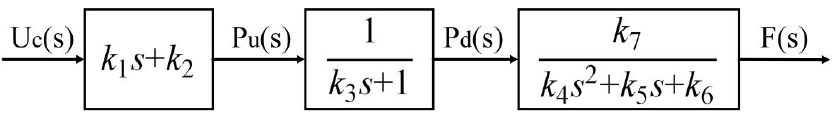
Figure 4. The transfer function of the system.